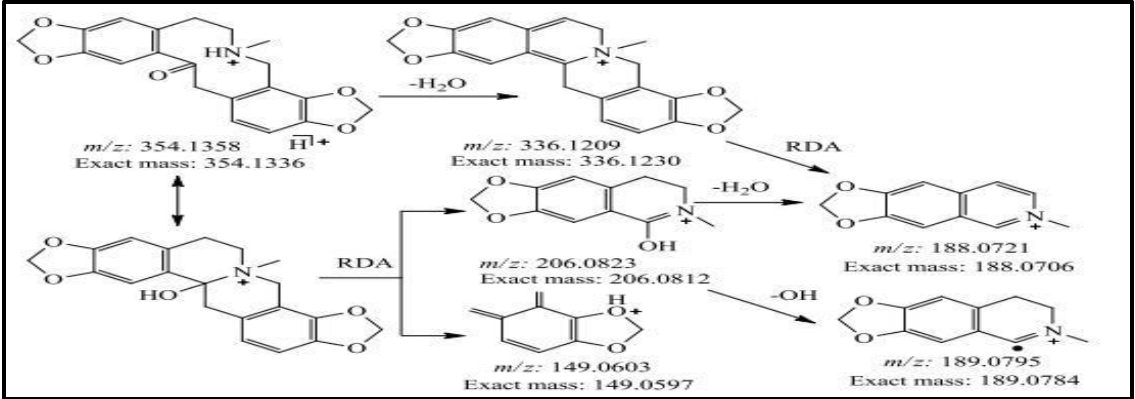
Figure 14 . MS/MS fragmentation pathway of protopine. (27) .